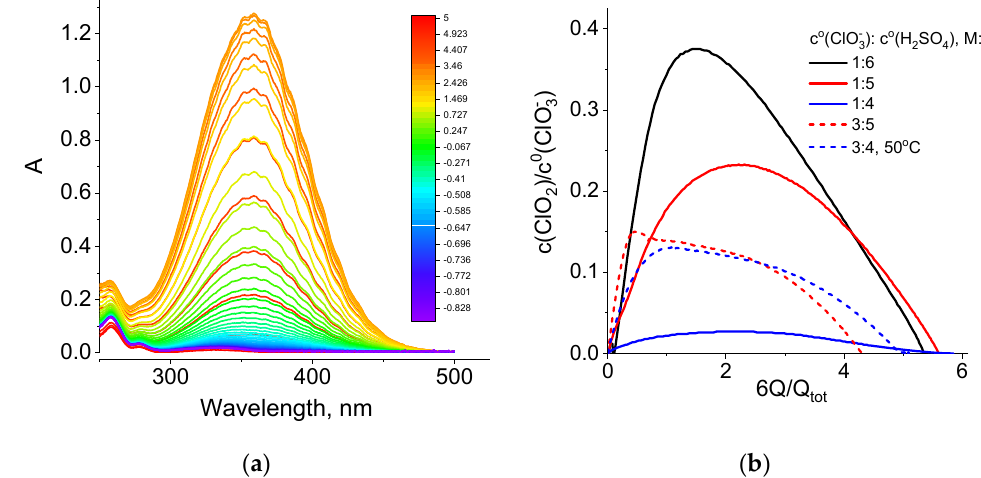
Figure 5. ( a ) Absorption spectra of the NaClO 3 + 4 M H 2 SO 4 catholyte (optical path length: 380 μ m) in the course of the potentiostatic load experiment at a voltage of 0.7 V (black curve in Figure 3, line 1 of Table 1). Scale colors in the figure indicating colors of spectral lines correspond to the average oxidation degrees of Cl atoms in solution, which was calculated by the following formula: 5 − Q/Q tot . ( b ) Dependence of the relative content of chlorine dioxide inside the catholyte (c(ClO 2 )/c 0 (ClO 3 − ), where c 0 (ClO 3 − ) is the initial concentration of chlorate) on the value of the transferred charge (Q) expressed in redox equivalents of chlorate anions, (6Q/Q tot